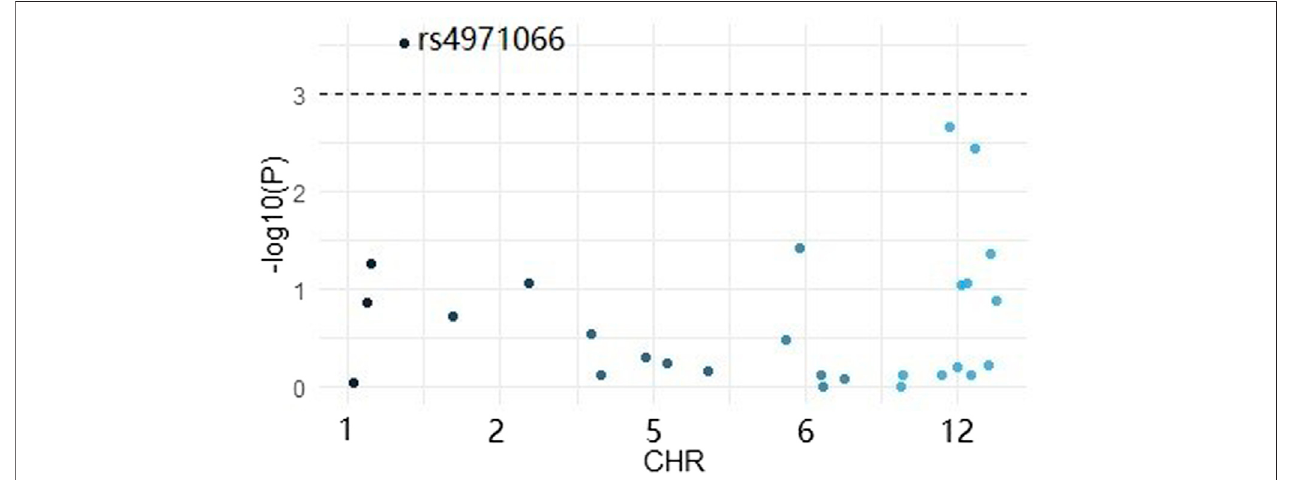
FIGURE 1 | Manhattan plot for the 29